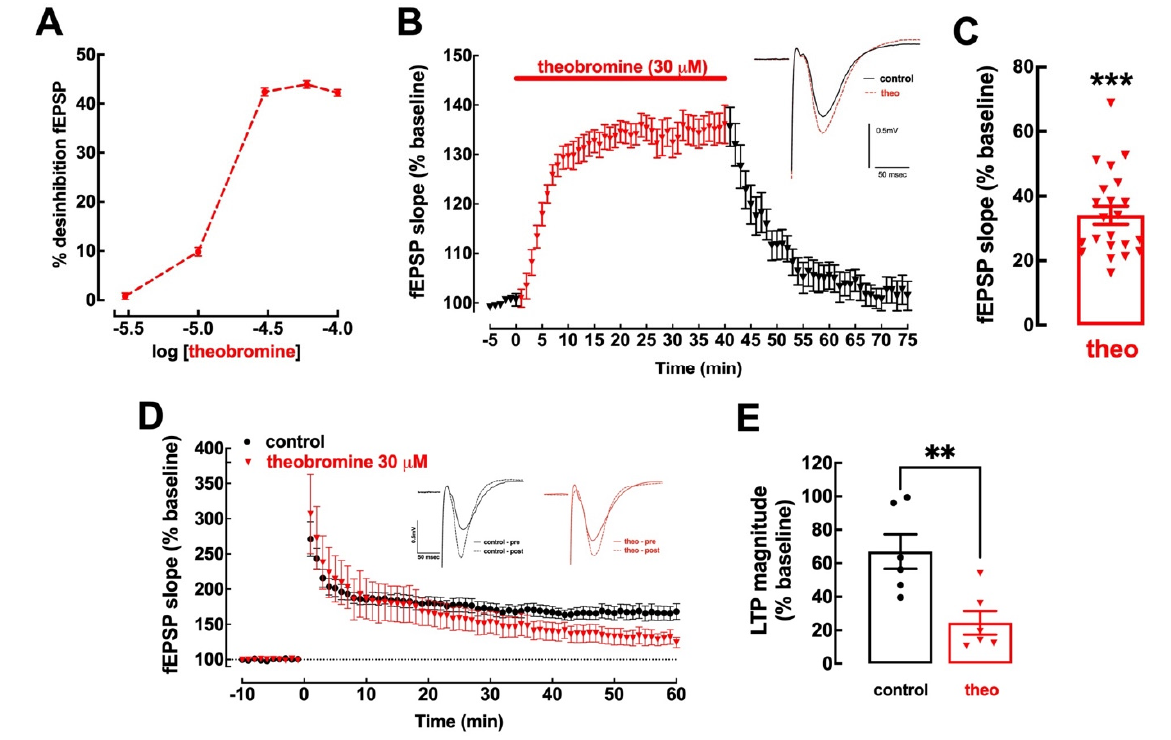
Figure 1. Theobromine alters basal synaptic transmission and synaptic plasticity. Theobromine increased basal synaptic transmission in Schaffer fibers-CA1 pyramid synapses of mouse hippocampal slices in a concentration-dependent manner, reaching a plateau after 30 μ M ( A ). Theobromine (theo, 30 μ M) rapidly and reversibly increased basal synaptic transmission ( B , C ), and the insert in ( B ) displays representative field extracellular postsynaptic potential (fEPSP) recorded in ACSF medium (control conditions, black filled line) and in the presence of theobromine (red dashed line). Additionally, theobromine significantly decreased the magnitude of long-term potentiation (LTP): the time course of fEPSP recordings ( D ) shows a sustained increase in fEPSP slope after delivering a high-frequency stimulation train (HFS: one train of 100 pulses of 1 Hz for 1 s), which is larger in ACSF (black symbols) than in the presence of 30 μ M theobromine (red symbols), as quantified in ( E ). The inserts in ( D ) show two superimposed pairs fEPSP collected before (filled traces) and 60 min after HFS (dashed lines) in control conditions (black traces on the left) and in the presence of theobromine (red traces on the right). Data are mean ± S.E.M. of 5–22 ( A ), 22 ( B , C ) or 6 ( D , E ) experiments. The asterisks denote significant differences: ** p < 0.01 vs. control, Student’s t test ( E ); *** p < 0.001 vs. baseline, one-sample t test ( C ).